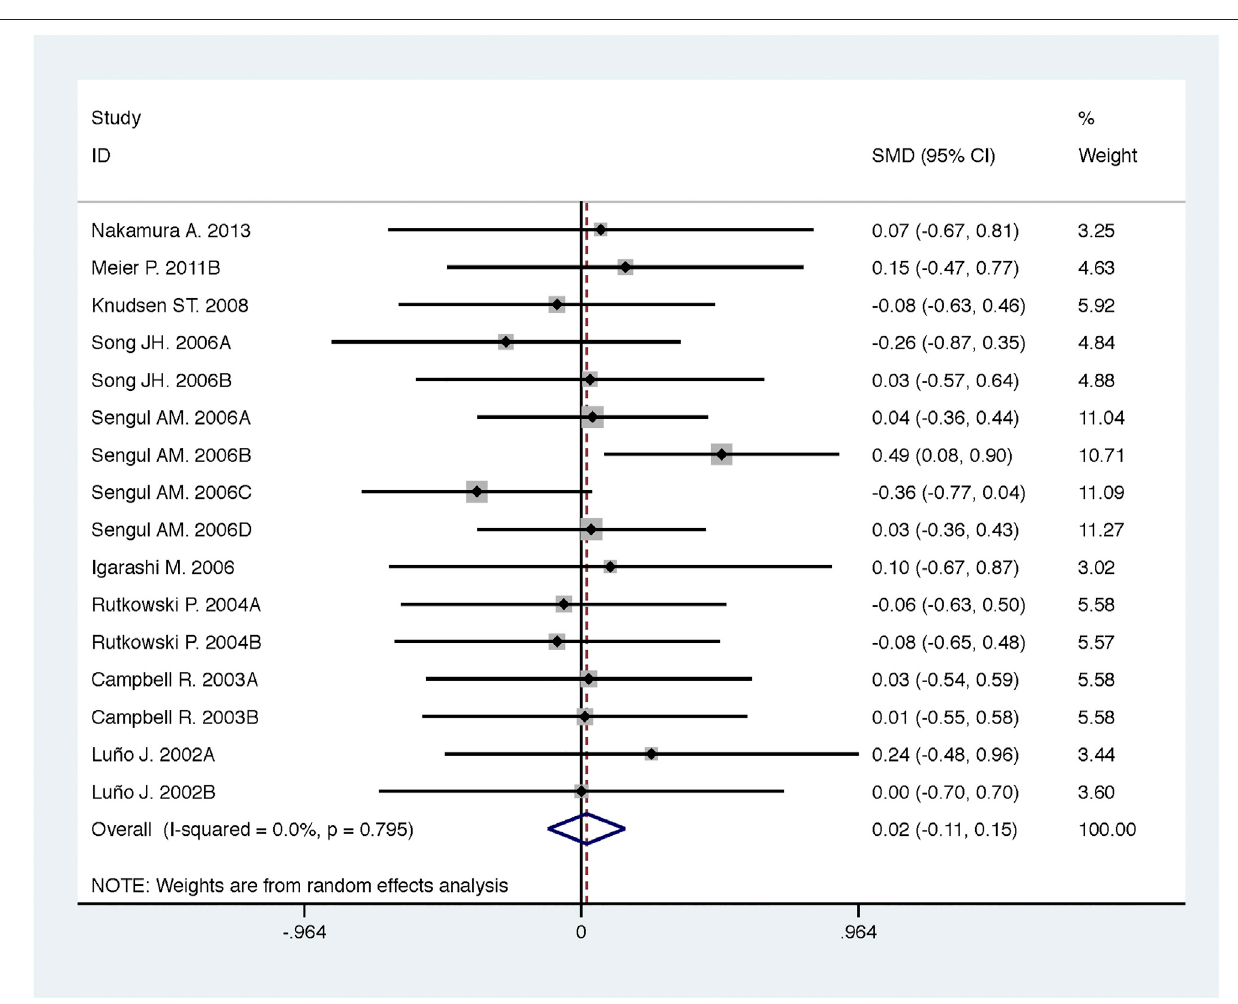
Frontiers in Pharmacology |